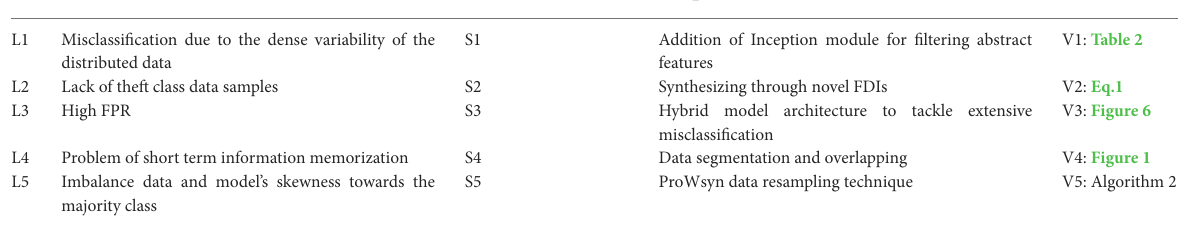
TABLE 1 Mappingoflimitationsandproposedsolutions.